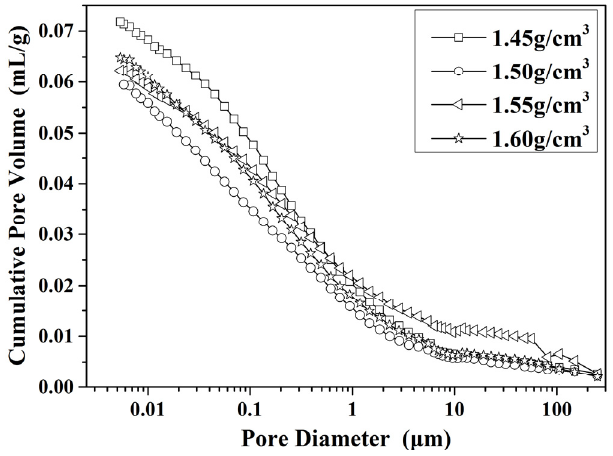
Figure 2. Cumulative pore volumes and diameters for samples with different dry densities (with logarithmic x-axis).